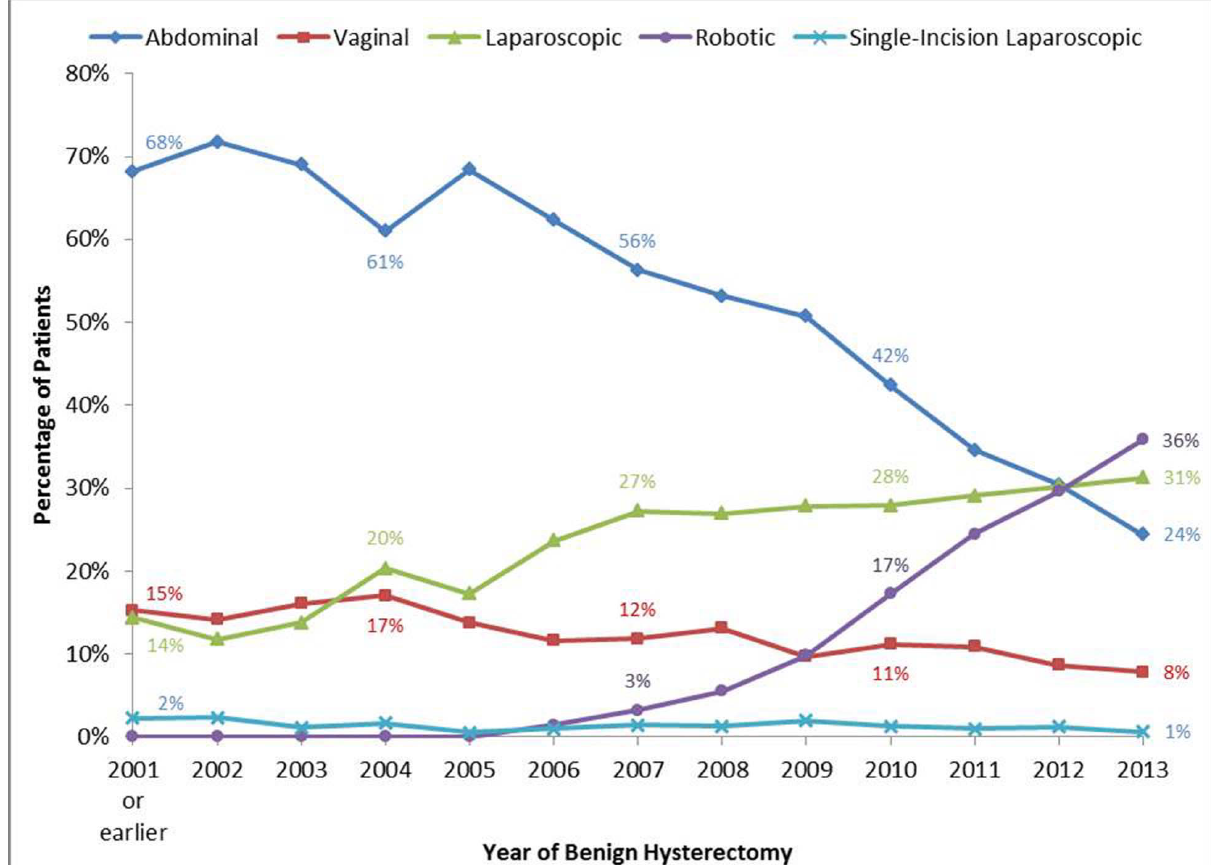
Figure 1. Trends in the use of each surgical approach over